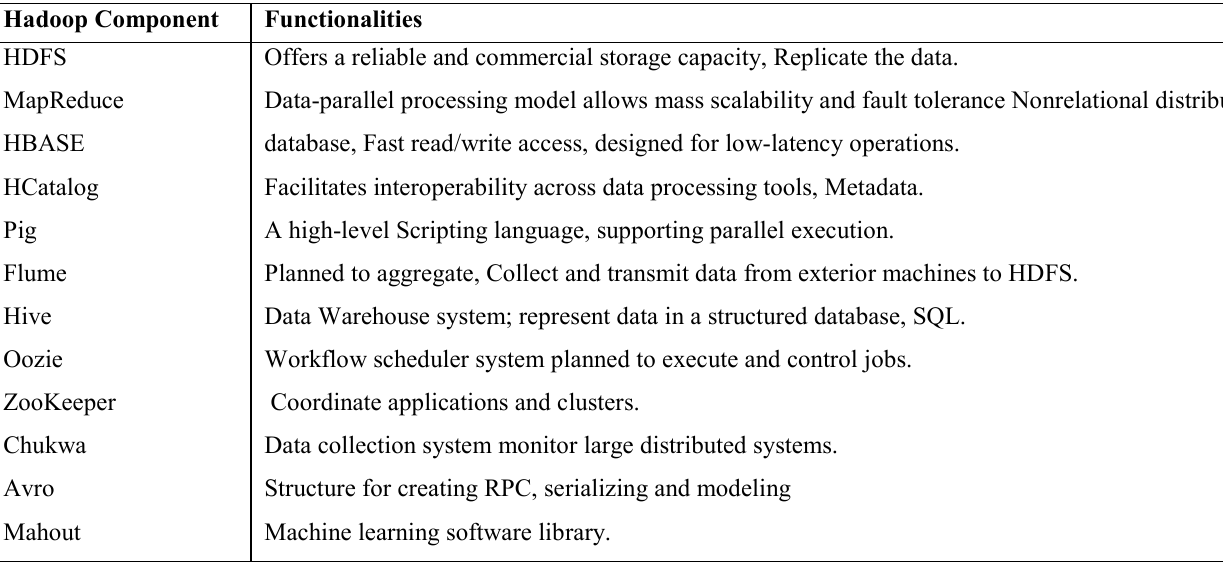
Table 1. Hadoop components and their